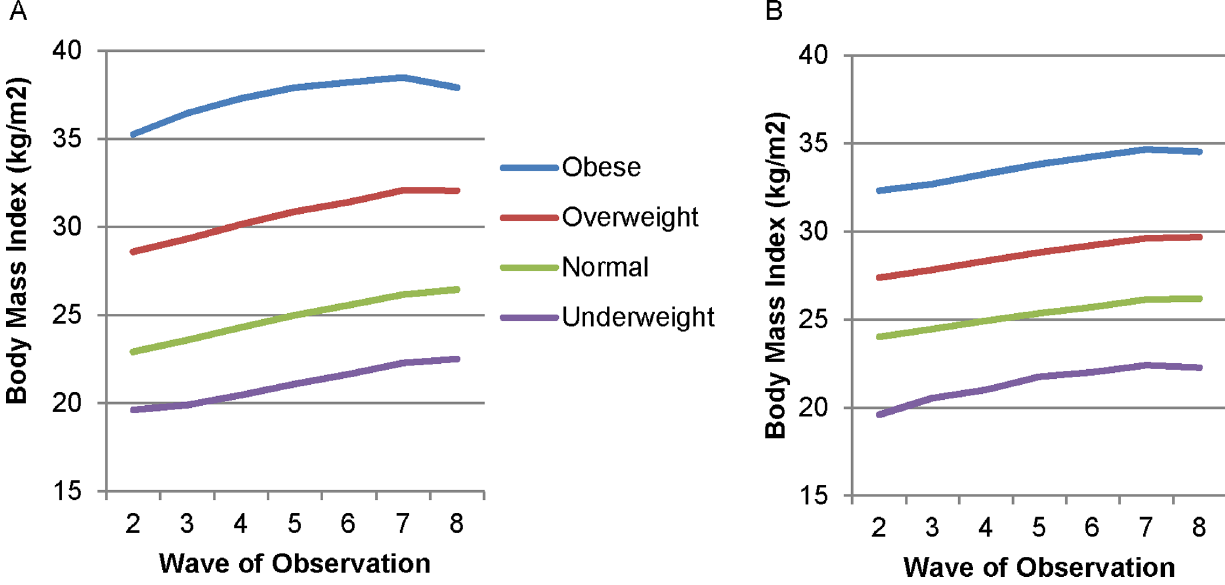
Figure 3. Body Mass Index Trajectories by Baseline Weight Classification, Framingham Heart Study Offspring Cohort, 1979–2008. Using results from the fully-adjusted models, we plotted the BMI trajectory for women (A) and men (B) based on their weight classification at baseline (during Wave 1, 1971–1975), controlling for covariates including baseline BMI. Weight classifications were underweight (BMI , 18.5 kg/m 2 ), normal weight (18.5 to 24.9), overweight (25 to 29.9), and obese ( $ 30). Lines represent trajectories for the typical male or female (mean age at each wave, married, employed, . high school education, non-smoker, consuming 1–2 alcoholic drinks daily, living in a census tract at mean poverty level, with mean baseline BMI for that weight